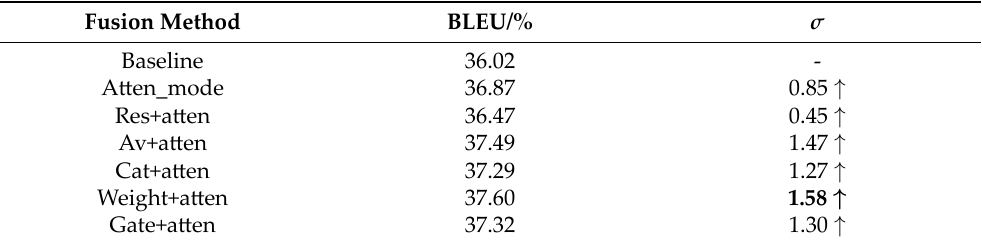
Table 3. BLEU value of comprehensive improvement experiment.